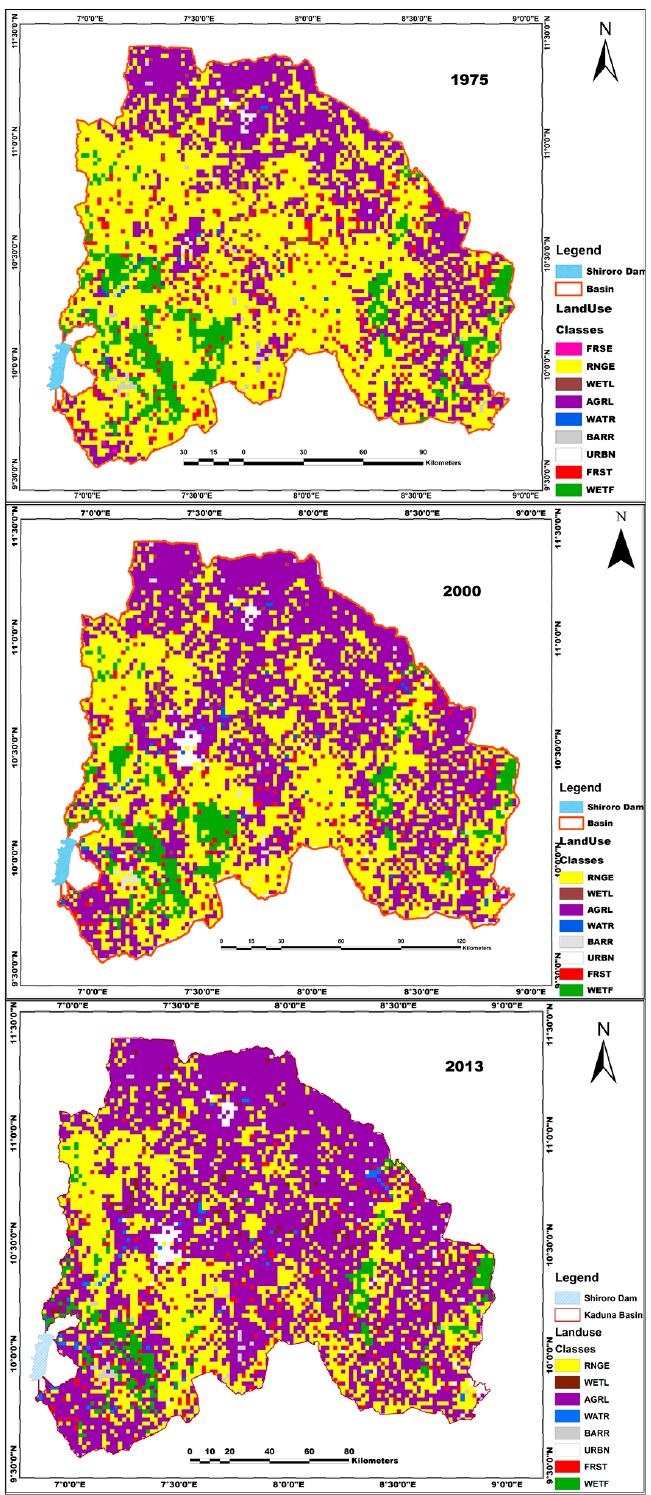
Figure 2. Comparative maps showing land use variation across 38 years. Note the relative increase in the area covered by agricultural land (AGRL), vis-à-vis the general decrease of range land (RNGE) and wetland forest (WETF) between 1975 and 2013 in the study area.